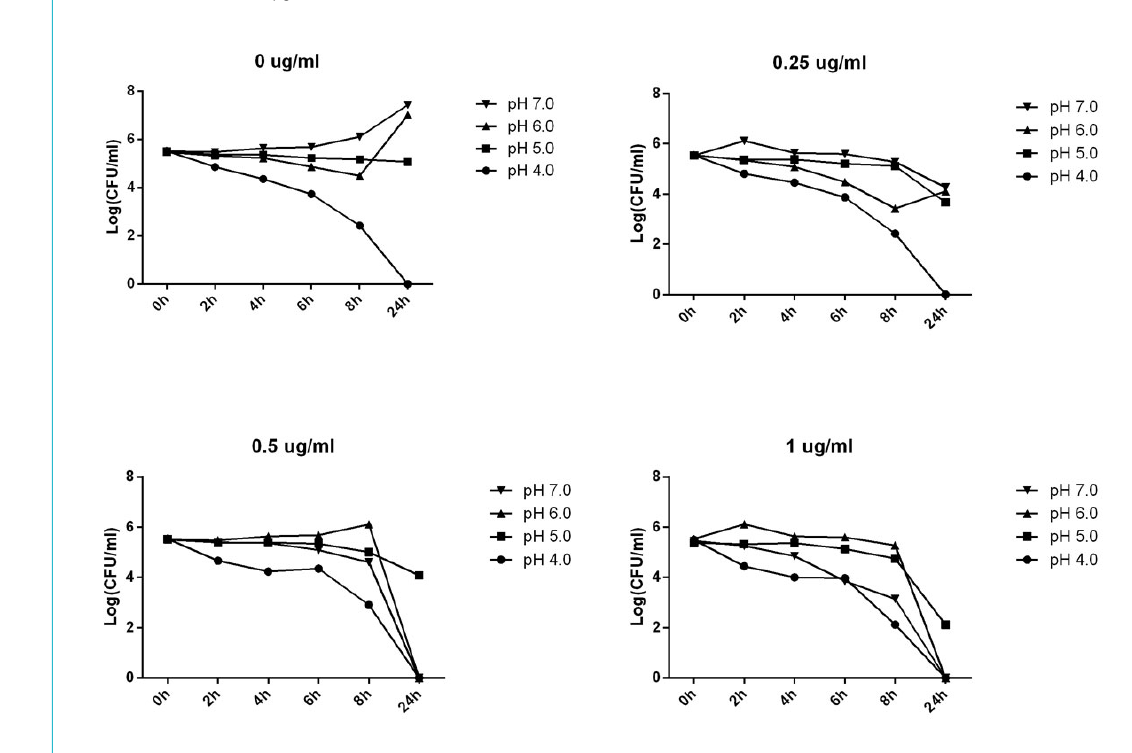
Figure 2: Determination of TNP-2092 in-vitro activity under different pH conditions. When the concentration of TNP-2092 was 0 µg/ml, H. py- lori could not survive at pH 4 and could not replicate well at pH 5. When the concentration of TNP-2092 was 0.25 µg/ml, its antibacterial activi- ty against H. pylori seemed to be reduced at pH 5 and 6 compared with pH 7. Similar results were obtained when the concentration of TNP-2092 was 0.5 and 1.0